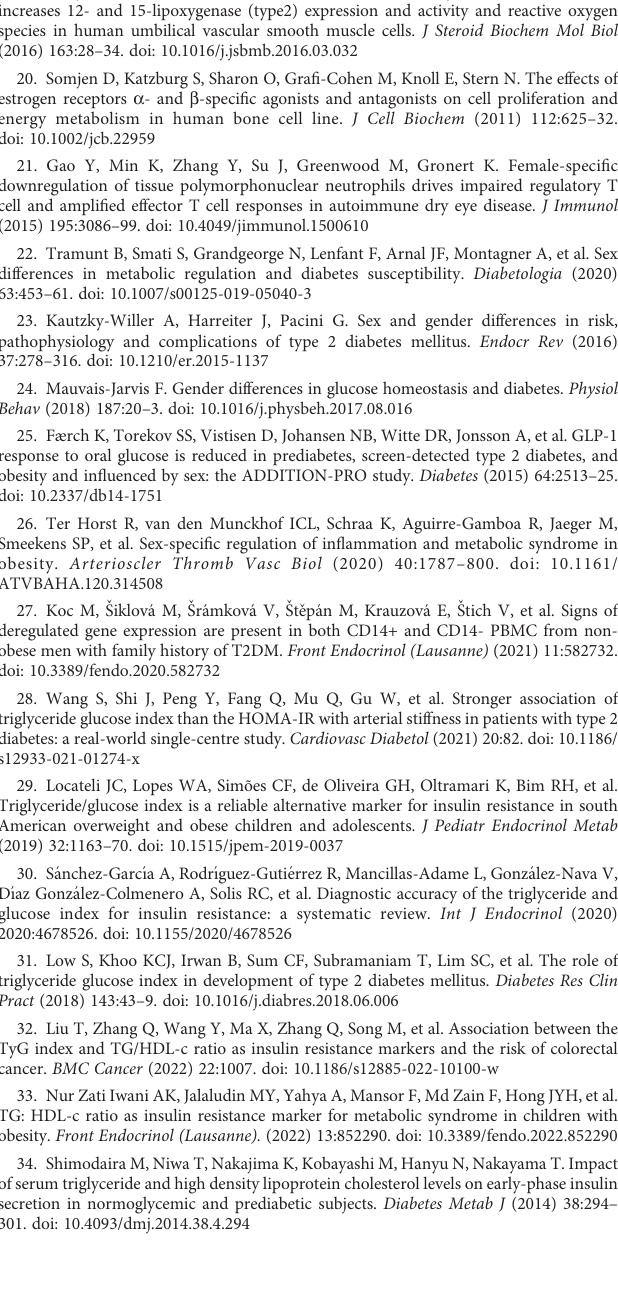
SUPPLEMENTARY FIGURE 1 Flow chart of study population. SUPPLEMENTARY FIGURE 2 Cumulative incidence of T2DM based on the optimal cutoff value of baseline LXA4. SUPPLEMENTARY FIGURE 3 Association between baseline LXA4 and the risk of T2DM. Baseline LXA4 was assessed as a continuous variable using restricted cubic spline regression, adjusted for age, gender, BMI, smoking, alcohol consumption, hypertension, dyslipidemia, hs-CRP, family history of diabetes and physical activity. P -values for linearity: